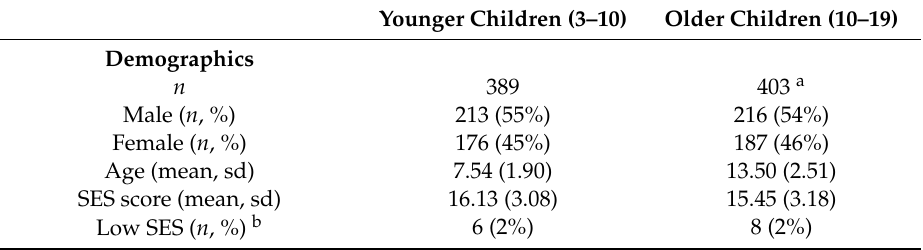
Table 1. Description of the study samples (younger children and older